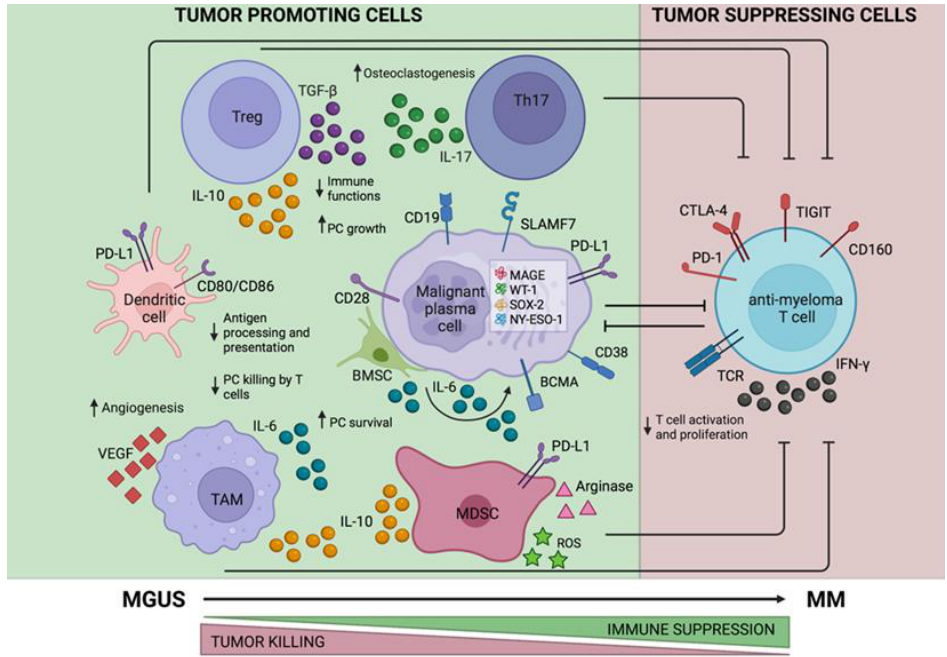
Figure 1. MM-associated immunological BM niche. Disease progression from MGUS to MM is associated with changes in the BM immune microenvironment, with progressive impairment of tumor suppressing cells (mainly anti-MM effector T cells) and accumulation of tumor promoting cells , such as regulatory T cells (Tregs), Th17 cells, tumor associated macrophages (TAMs), myeloid- derived suppressor cells (MDSCs), and suppressive dendritic cells (DCs). ↓ : decrease; ↑ : increase; ⊥ : inhibition; PC: plasma cell; BMSC: bone marrow stromal cells; SLAMF7: signaling lymphocyte activation molecule family 7; BCMA: B-cell maturation antigen; MAGE: melanoma-associated